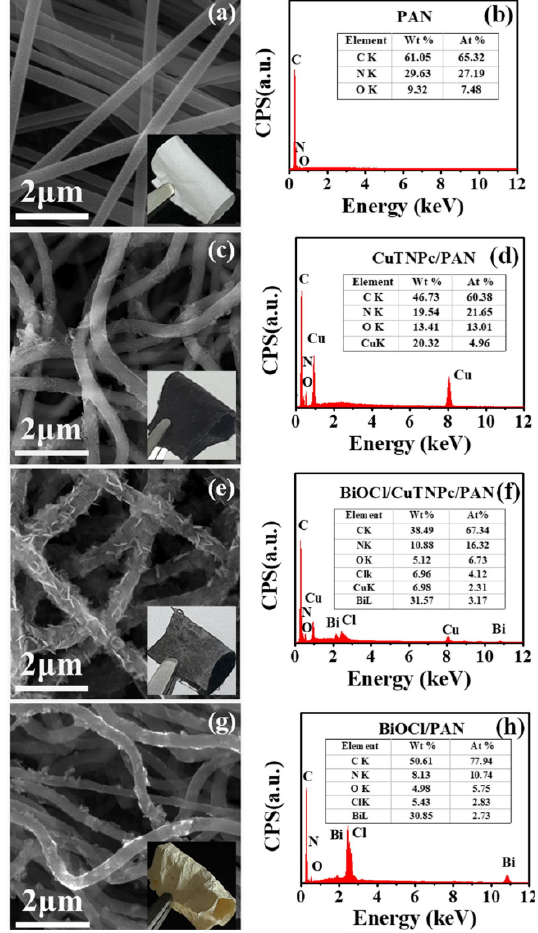
Figure 7. SEM images and EDX spectra of samples: ( a , b ) PAN, ( c , d ) CuTNPc/PAN, ( e , f ) BiOCl/CuTNPc/PAN, and ( g , h ) BiOCl/PAN. (Reprinted from the work of Guo et al. [34]. Copyright 2018, with permission from Elsevier).